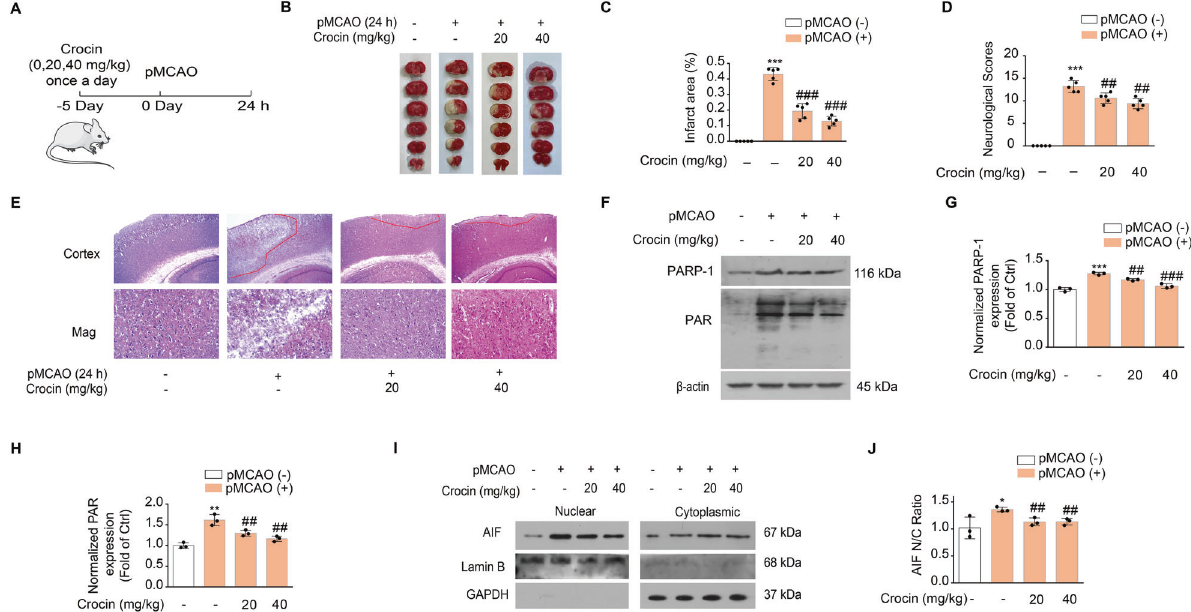
Fig. 1 Alleviation of brain injury in pMCAO rats after crocin pre-administration. A Scheme diagram of the experiment. Rats were pre-dosed with crocin (0, 20, and 40 mg/kg, p.o) once a day for 5 days before pMCAO for 24 h ( n = 5 per group). B TTC staining of brains slices collected at 24 h after onset of IS. C Quanti fi cation of cerebral infarct areas assessed by TTC staining. D Average modi fi ed neurological severity scores (mNSS). E Histopathological examination was performed by H&E staining. F – H Western blot ( F ) and group quanti fi cation of PARP-1 ( G ) and PAR ( H ) from three independent experiments. I AIF translocation was assessed by western blot. J Group quanti fi cation of gray intensity in ( I ) from three independent experiments. Signi fi cance was determined by one-way ANOVA. * p < 0.05, ** p < 0.01, *** p < 0.001, vs control group; ## p < 0.01, ### p < 0.001, vs pMCAO